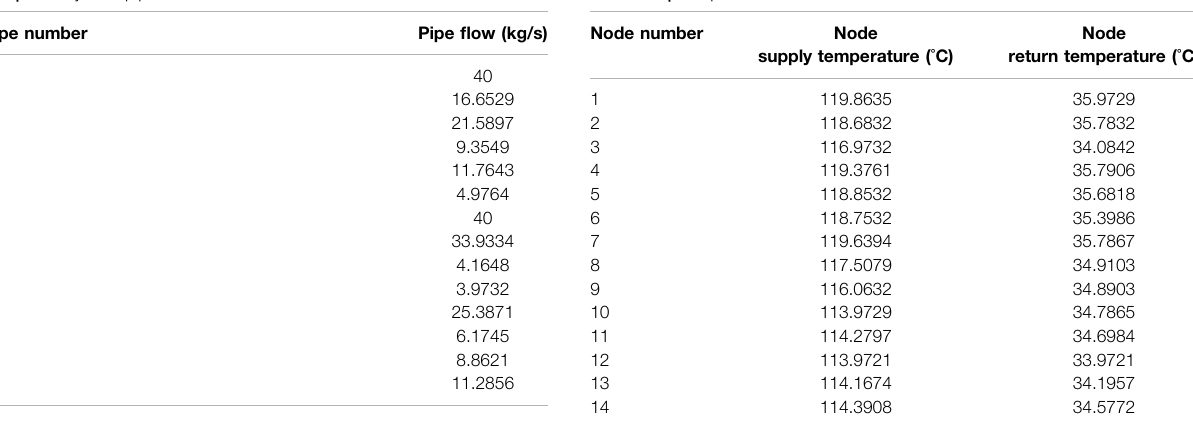
TABLE 1 | Heat system pipeline fl ow. TABLE 2 | Temperature at each node in the heat